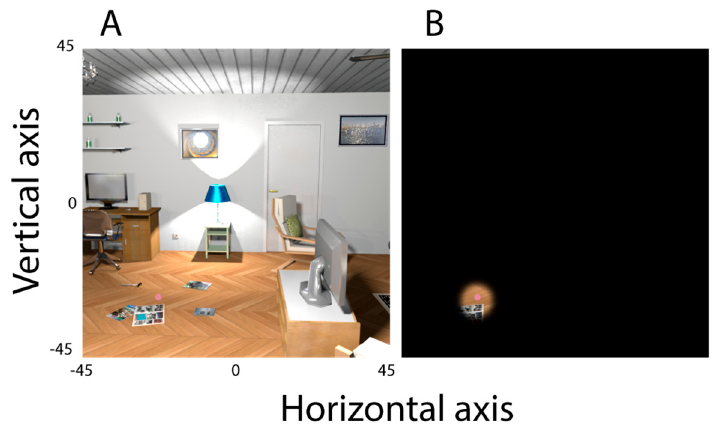
Figure 4. Portion of the virtual environment explored by subjects during visual search ( A ). In this example, a pink target appeared randomly in the left-bottom corner of the virtual environment. Subject perceived the virtual environment through a simulated tunnel vision ( B